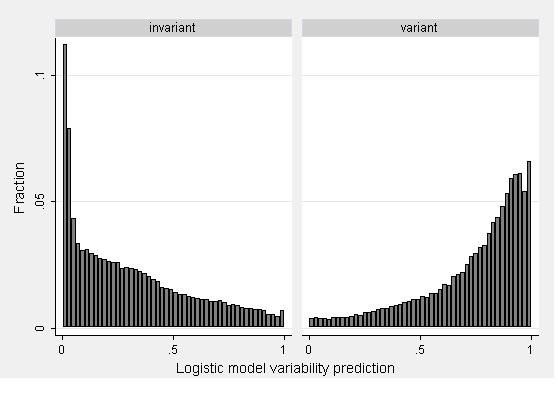
Histogram of predictions from the generic logistic regression model, broken down according to whether or not the repeats were variable.